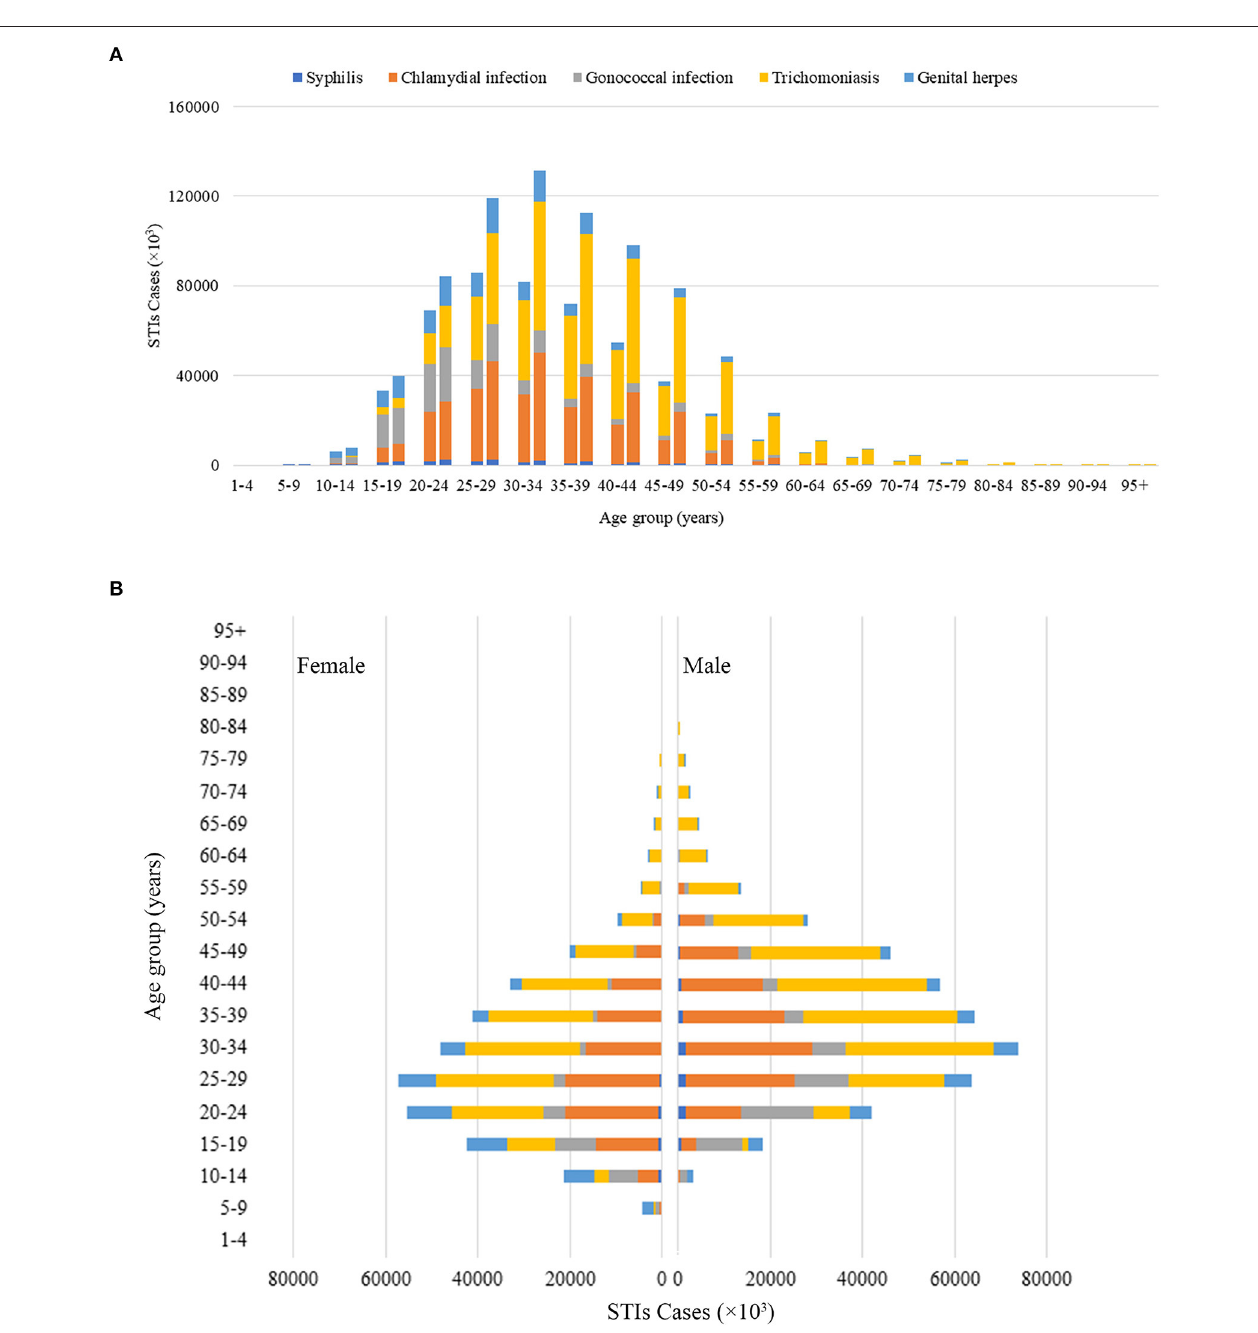
FIGURE 2 | Global STIs incident cases by 20 GBD age groups. (A) Global STIs incident cases by age for men and women combined in 1990 and 2019. For each group, the left column presents case data from 1990 and the right column presents data from 2019. (B) Difference by gender in global STI incident cases by age in 2019 GBD, Global Burden of Disease; STIs, sexually transmitted